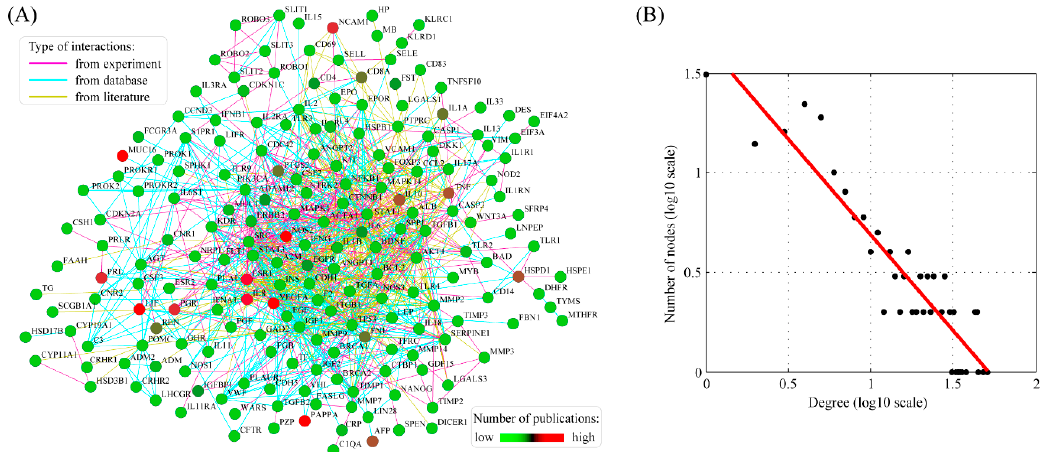
Figure 2. The gene network underlying ectopic pregnancy susceptibility genes. ( A ) The structure of the gene network generated by the STRING software. The number of publications for each gene was represented in color gradient with a scale bar; ( B ) Degree distribution of the gene network. The degree distribution follows a power law distribution. With 95% confidence interval, the scaling exponent is estimated to be 0.9614 ± 0.1346.